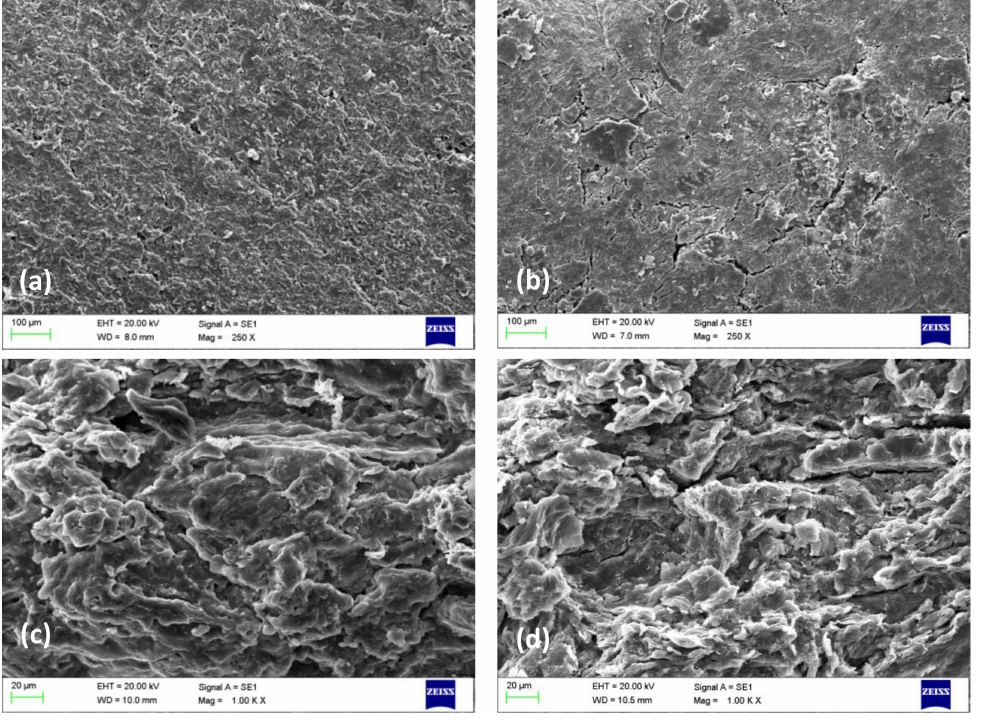
Figure 3. Fiberboards prepared from non-washed apple pomace without the addition of glycerol ( a and c ) show a more connected, smoother structure compared to the ones made from washed apple pomace with the addition of glycerol ( b and d ), which had cracks in the structure. Images of ( a ) and ( b ) are taken of the surfaces of specimens; while ( c ) and ( d ) are cross-sectional images. Micrographs were taken respectively, at 250 × and 1.00 K × magnifications using a 20.00 kV accelerating